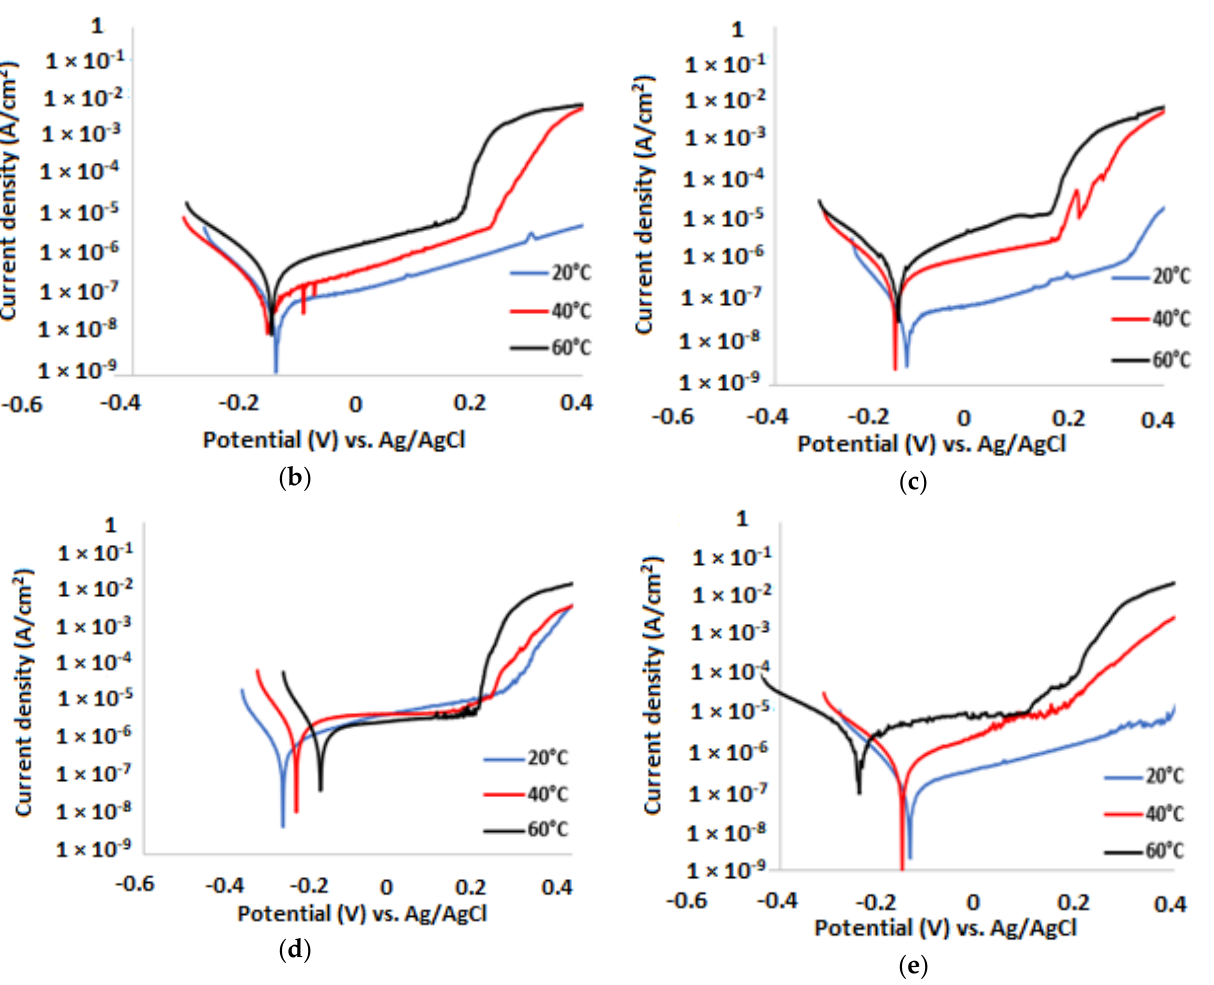
Figure 4. Potentiodynamic polarisation curves of 304 SS in 3.5% NaCl solution with ( a ) 304 SS without inhibitor, ( b ) Ce ( acac ) , ( c ) Ce ( hfac ) , ( d ) La ( acac ) , and ( e ) La ( hfac )